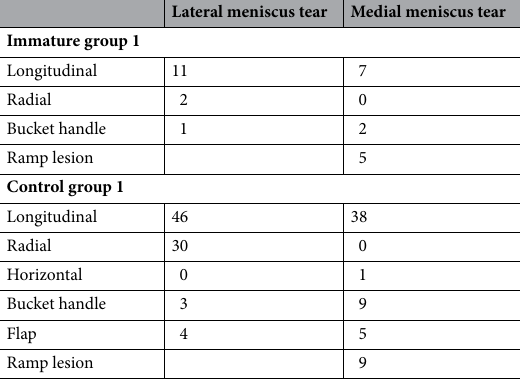
Table 2. Details of meniscal tear.